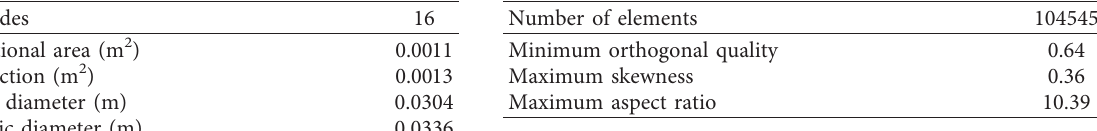
Figure 2: (a) Geometry of a compressor row with boundary conditions (b) Geometry of a compressor row with the blade. Table 3: Compressor blade geometry information. Table 4: Information on grid computation model.